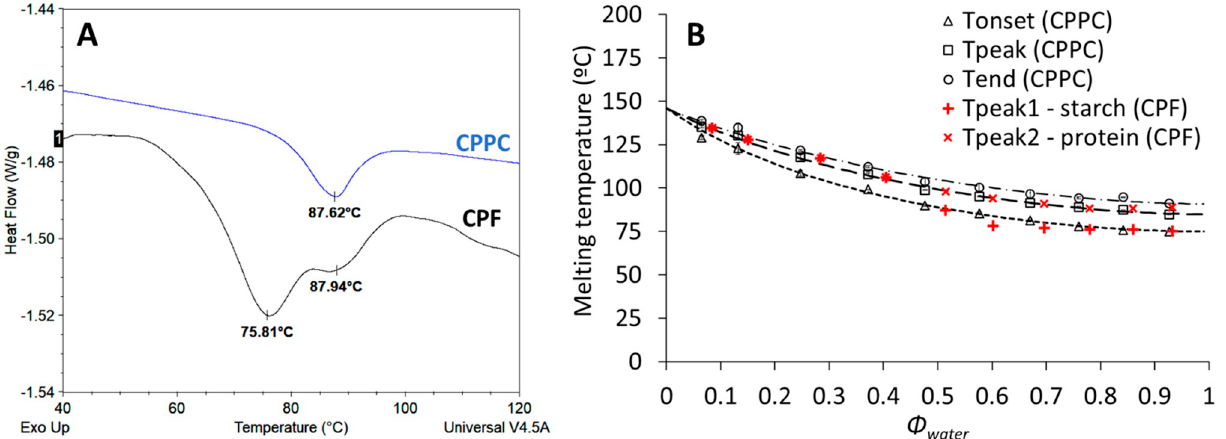
Figure 2. DSC thermograms of CPPC and CPF showing the melting transitions of proteins (i.e., 88 °C) and starch (i.e., 76 °C) ( A ); melting temperatures of proteins in CPPC (black symbols) and of proteins and starch in CPF (red symbols) as a function of Φ water . The dotted black lines represent the FH model describing the melting transitions ( B ).